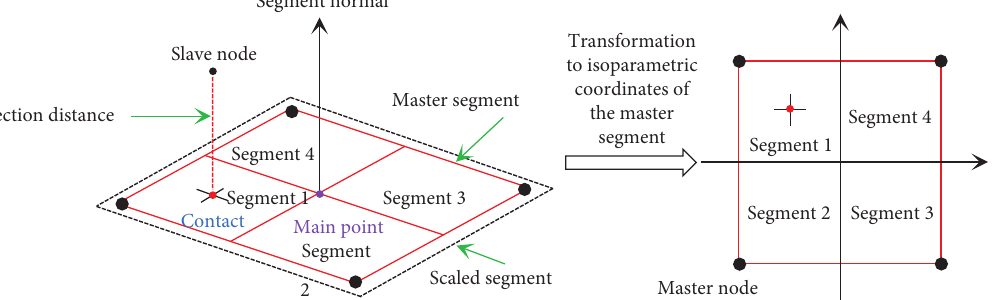
Figure 11: An assemblage of slave node-master segment pair (Vignjevic et al. [49]).